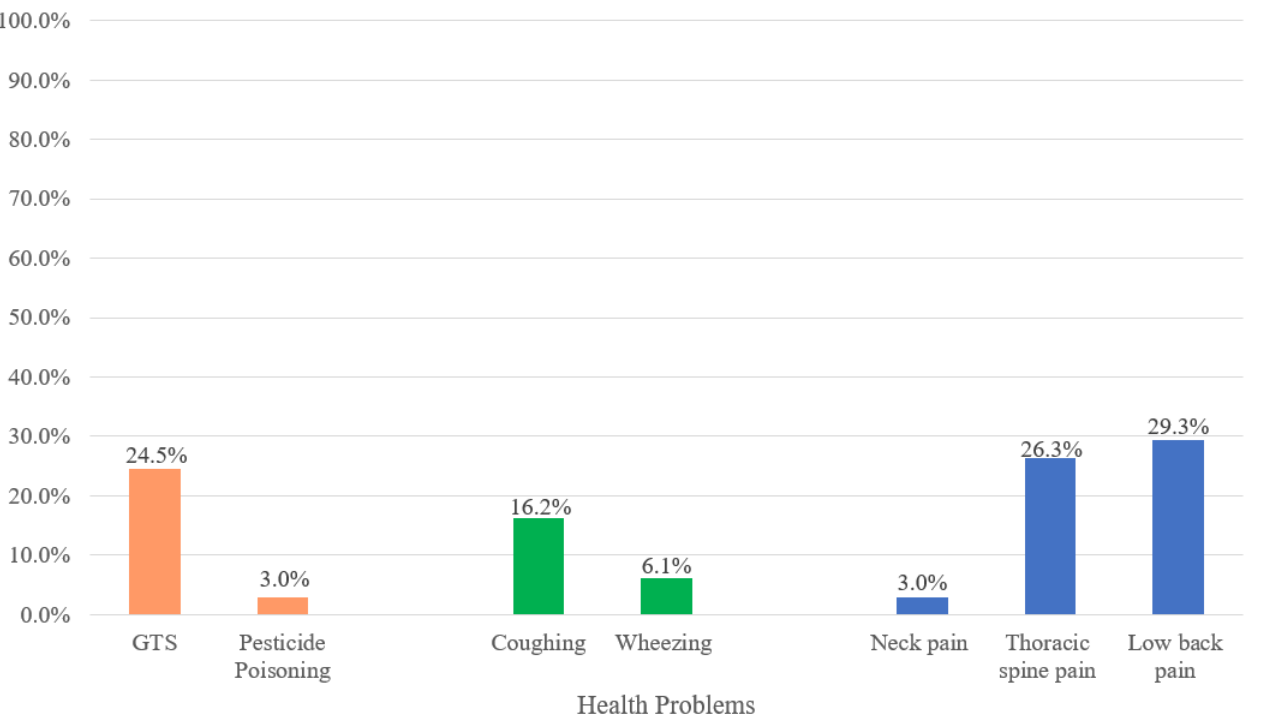
Figure 1. Prevalence of Health Problems among Children Tobacco Growers. São Lourenço do Sul, Rio Grande do Sul, Brazil, 2011 ( n = 99).